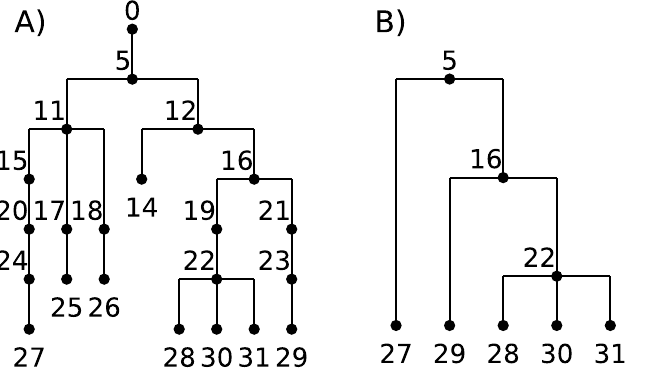
Fig 4. An example of a marginal genealogy from a Wright-Fisher simulation with N = 5. (A) the original tree including all intermediate nodes and dead-ends, and (B) the minimal tree relating all of the currently-alive individuals